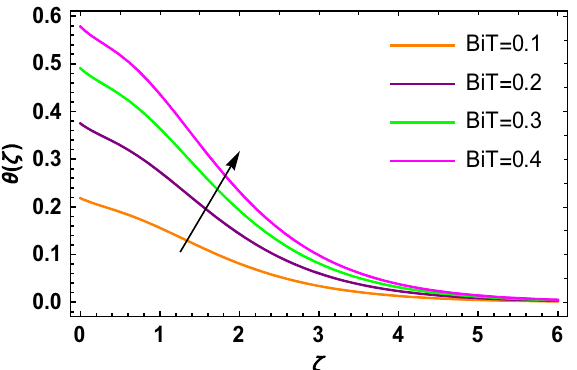
Figure 6. θ(ζ) versus Bi T .